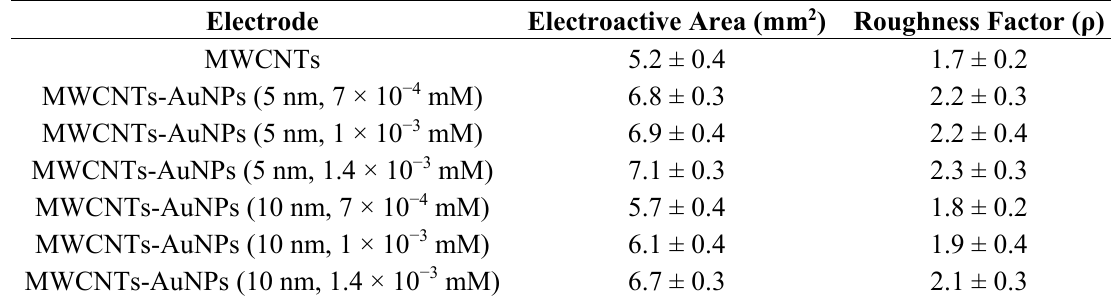
Figure 2. Cyclic voltammograms of 0.1 mM potassium ferricyanide solution at unmodified multi-wall-carbon-nanotubes (MWCNTs) (red curve) and at MWCNTs modified with AuNPs of 5 nm diameter (Figure 2a) and of 10 nm (Figure 2b) at the following concentrations: 7 × 10 − 4 M (green curve), 1 × 10 − 3 M (black curve), 1.4 × 10 − 3 mM (blue curve). Experimental conditions: 0.1 M phosphate buffer pH 7; scan rate 5 m·Vs − 1 . Table 2. Values of the electroactive area and roughness factor of the unmodified and modified MWCNTs electrodes with 5 nm and 10 nm diameter AuNPs at different